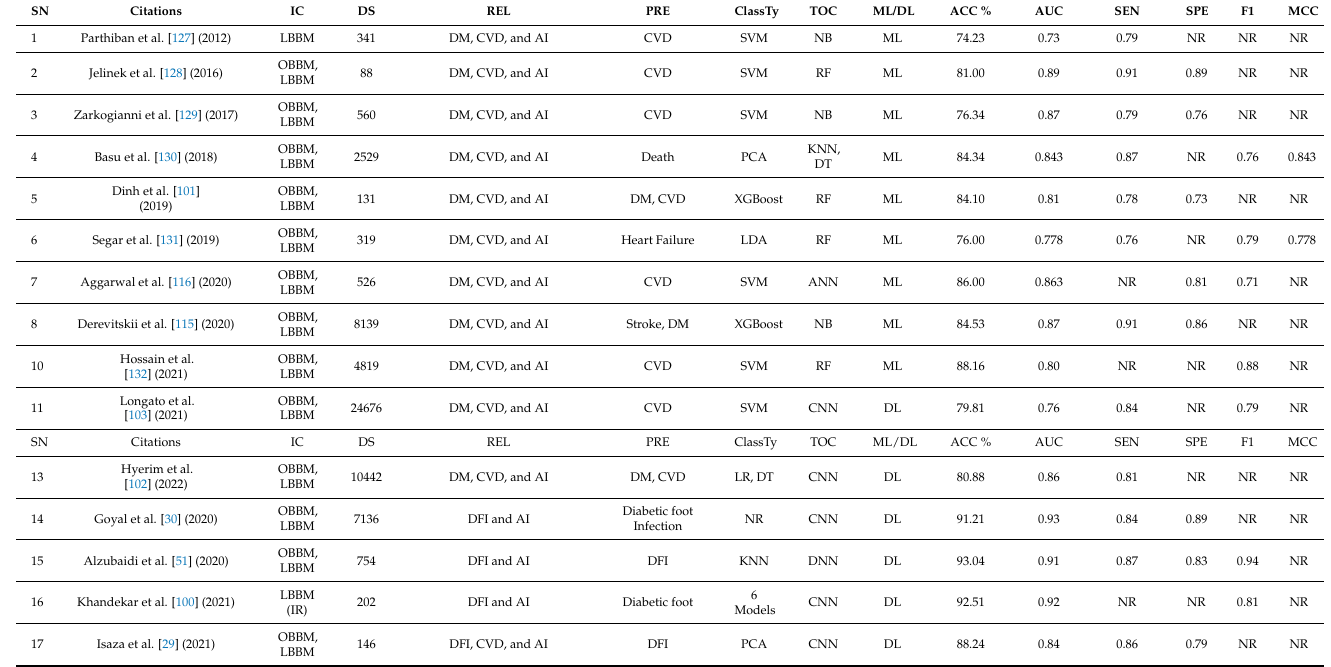
Table 2. Studies show the role of AI in the diagnosis, and prediction of, DM, DFI, and